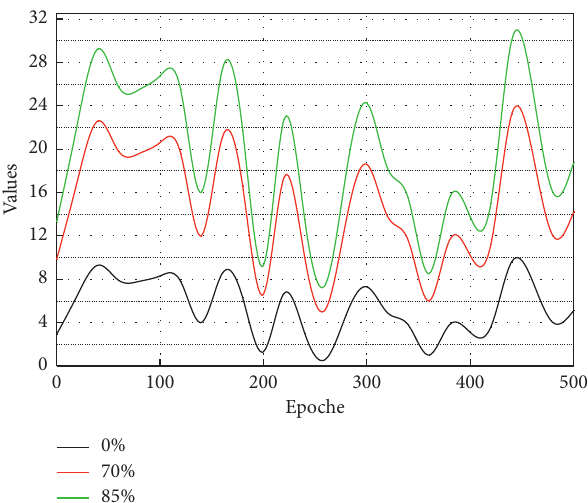
Figure 6: Model efficiency curve.